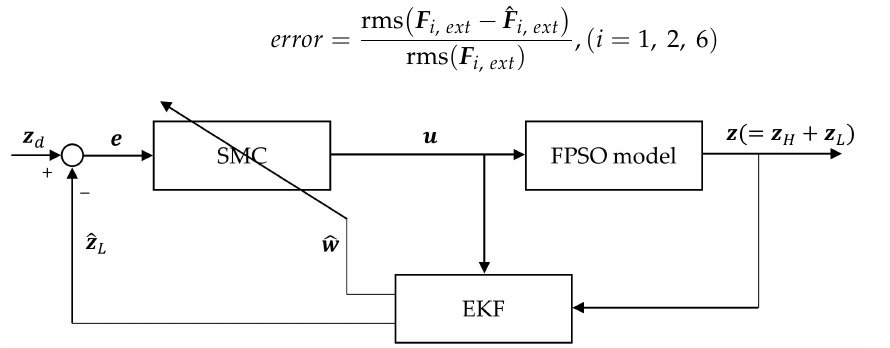
Figure 8. Structure of the sliding mode control with extended Kalman filter.